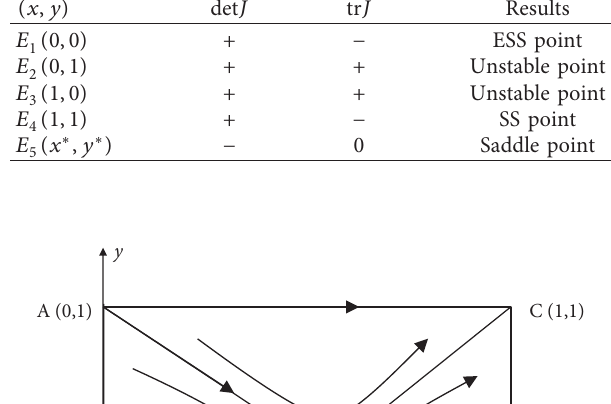
Figure 3: Phase diagram of Model III.